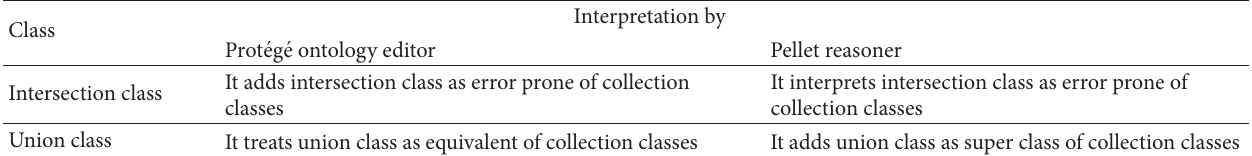
Figure 1: Union class example.